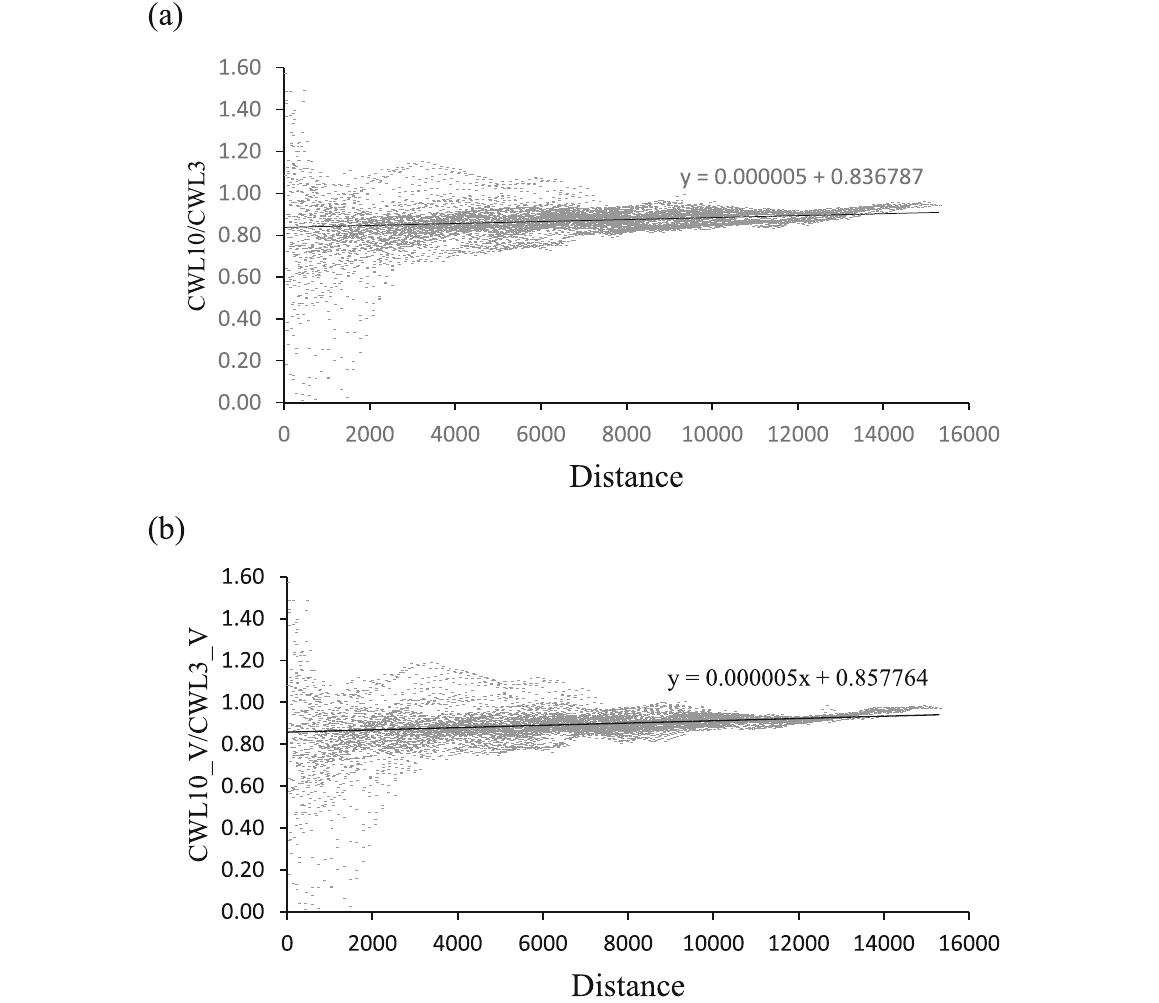
Fig. 8 Plot of 9203 sample values of a CWL10/CWL3 and b CWL10_V/CWL3_V against straight-line distance from the source patch. Note that the portion of the plot (containing 14 values) where CWL10/CWL3 > 1.60 are not shown here for ease of